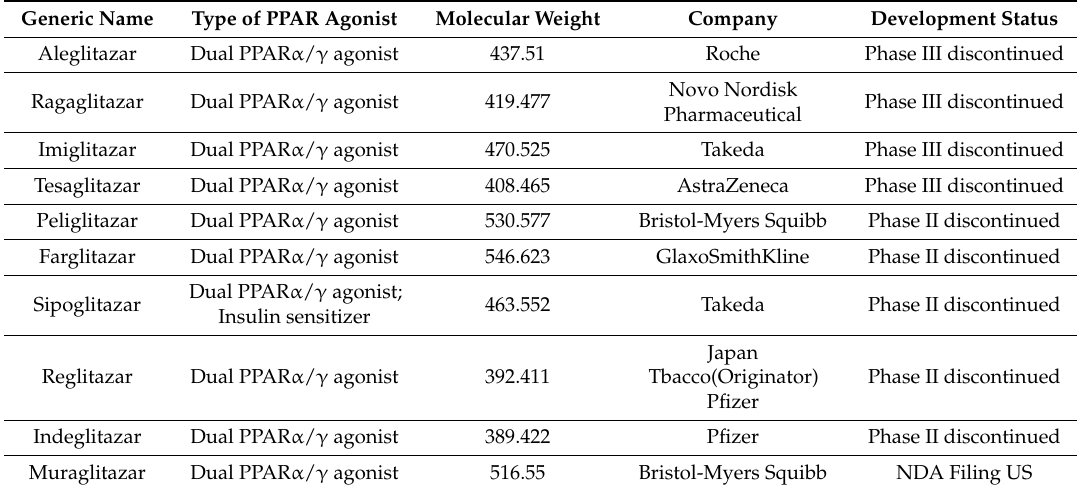
Table 4. Dual PPAR α / γ agonist “glitazar” for type 2 diabetes